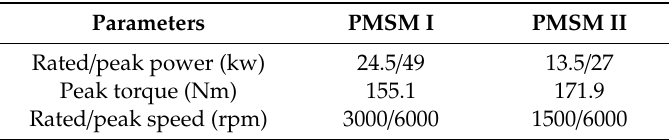
Table 2. Key parameters of the